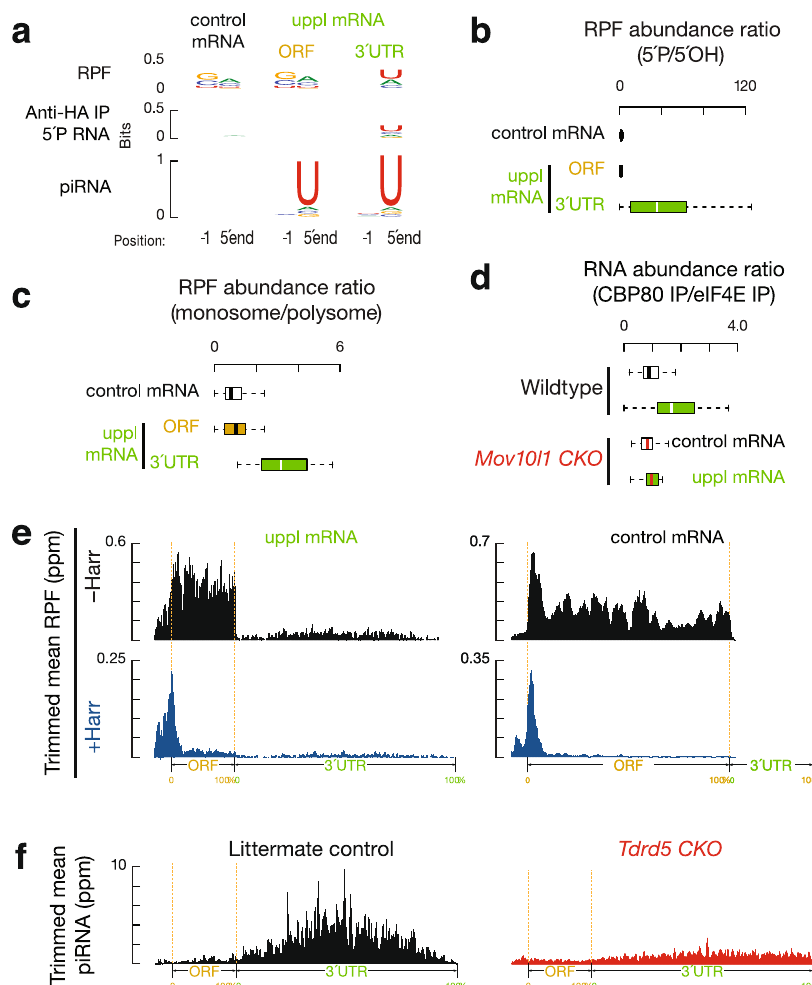
Fig. 4 Biphasic piRNA biogenesis. a Sequence logos depicting nucleotide (nt) bias at 5 ′ -ends and 1 nt upstream of 5 ′ -ends. Top to bottom: RPF species, anti-HA-immunoprecipitated 5 ′ P RNA species, and piRNAs in adult testes, which map to mRNAs, uppl mRNA ORFs, and 3 ′ UTRs, respectively. b Boxplots of the ratios of 5 ′ P RPF versus 5 ′ OH RPFs in adult wild-type testes. Control mRNA n = 43, uppl mRNA n = 30. c Boxplots of the ratios of RPF abundance in monosome fractions versus those in polysome fractions in adult wild-type testes. Control mRNA n = 43, uppl mRNA n = 30. d Boxplots of the ratios of RNA abundance in CBP80 IP versus eIF4E IP in adult wild-type (upper) and Mov10l1 CKO mutant (lower) testes. Control mRNA n = 43, uppl mRNA n = 30. e Aggregated data for RPF abundance from untreated adult testes (top) and from harringtonine-treated adult testes (bottom) across 5 ′ UTRs, ORFs, and 3 ′ UTRs of the uppl mRNAs (left) and control mRNAs (right). The x -axis shows the median length of these regions, and the y -axis represents the 10% trimmed mean of relative abundance. f piRNA abundance on uppl mRNAs (10% trimmed mean) in adult testes. Control (left) and Tdrd5 CKO (right). Box plots in ( b – d ) show the 25th and 75th percentiles, whiskers represent the 5th and 95th percentiles, and midlines show median